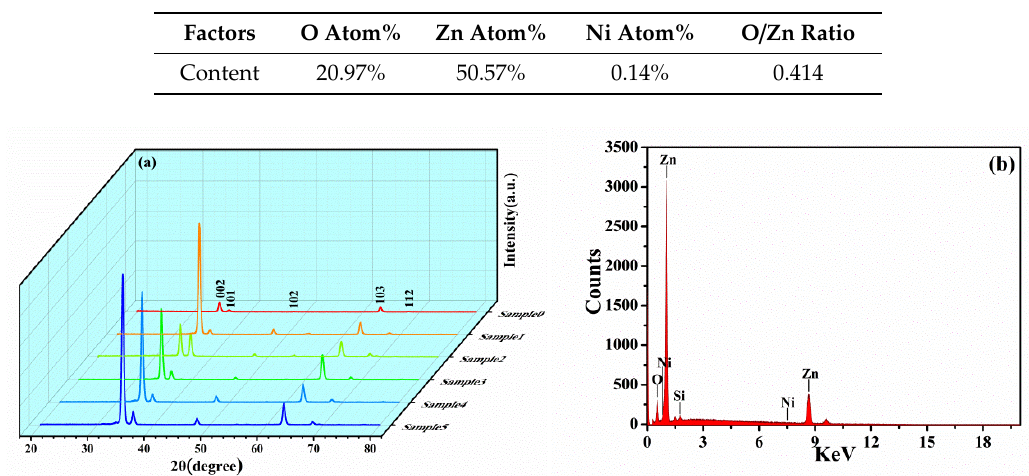
Table 2. The percentage of elements of Zn 1-x Ni x O nanorod arrays.